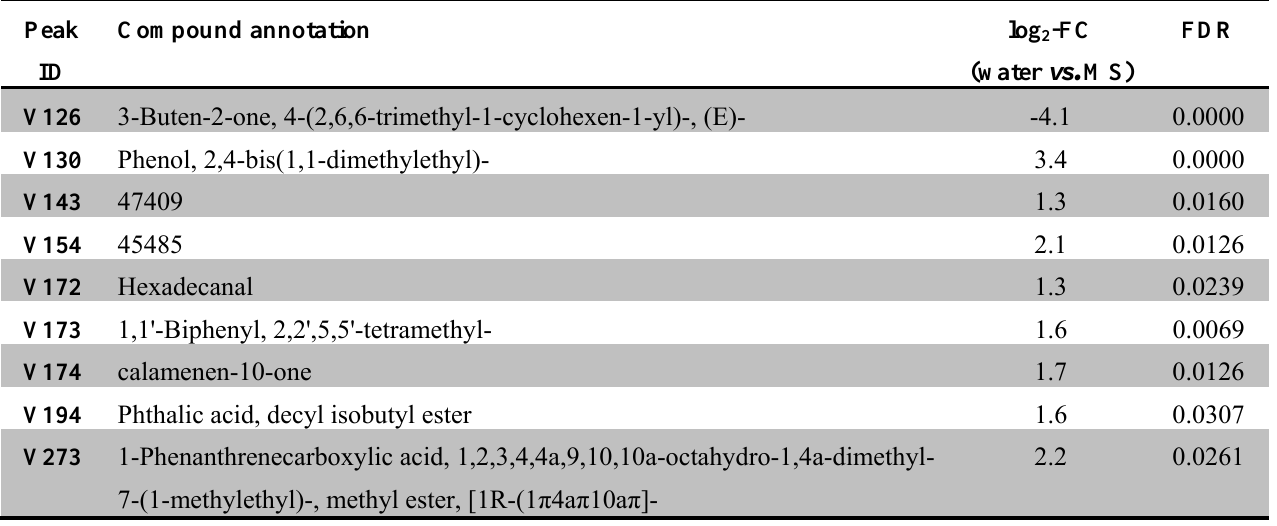
Table 2. Significant changes in the levels of annotated